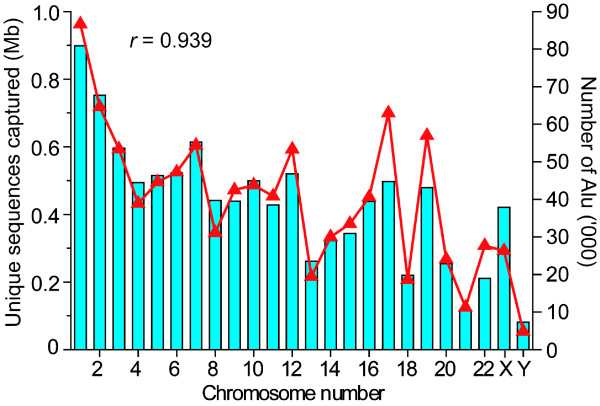
Correlation between number of Alu elements and sequences captured. Relationship between the number of Alu elements occurring on individual human chromosomes (blue bars) and the amount of AluScan-captured sequences of white blood cell DNA mapped to the different chromosomes (red triangles). Correlation coefficient was 0.939 between these quantities.